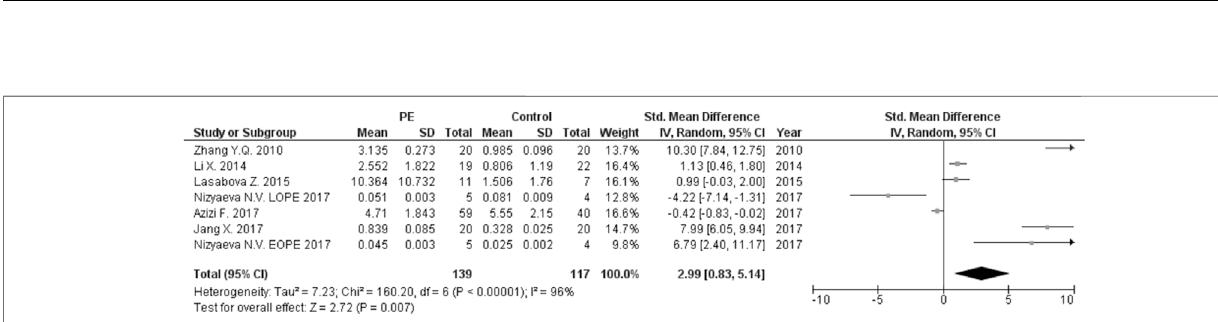
FIGURE 5 | Meta-analysis of differences in expression level of miRNA-29b in placenta between women with vs. without preeclampsia.